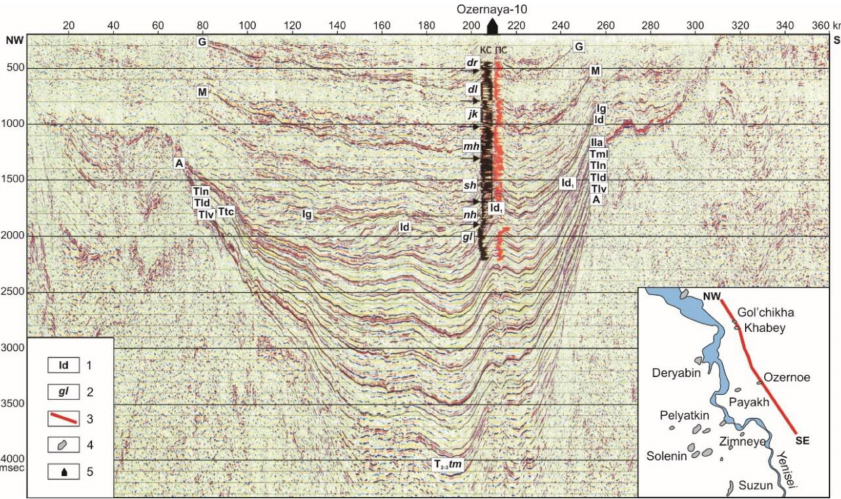
Figure 12. Stratified common depth point seismic section along the regional 1-1 line [81]. 1—seismic reflectors (their stratigraphic correlation is shown in Figure 11); 2—formations: